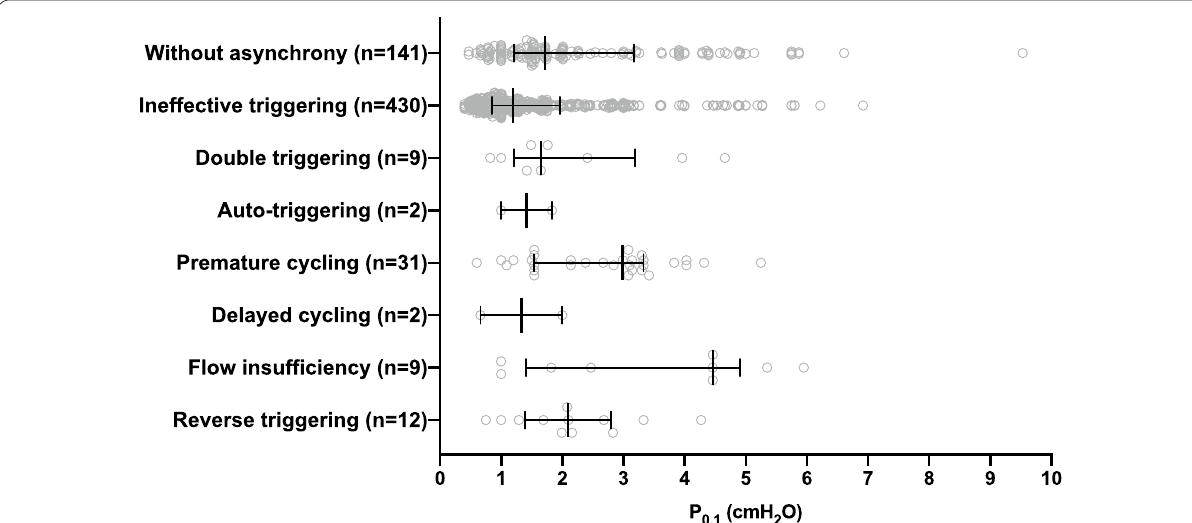
Fig. 5 The airway occlusion pressure (P 0.1 ) with different types of asynchrony. Individual data, median, and interquartile ranges are shown. Compared to the datasets without asynchrony, P 0.1 was significantly lower in datasets with ineffective triggering ( p < 0.001). Although there was a tendency in elevated P